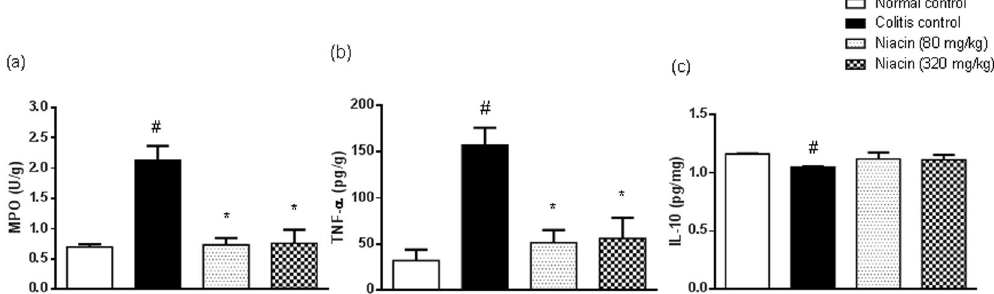
Figure 3. Effect of niacin on inflammatory and anti-inflammatory parameters in colonic tissues of rats with iodoacetamide-induced colitis. ( a ) Myeloperoxidase (MPO) activity, ( b ) tumour necrosis factor (TNF)- α levels, ( c ) IL-10 levels. Data are expressed as means ± SEM of 8 animals. # P ≤ 0.05 vs. normal control, * P ≤ 0.05 vs. colitis